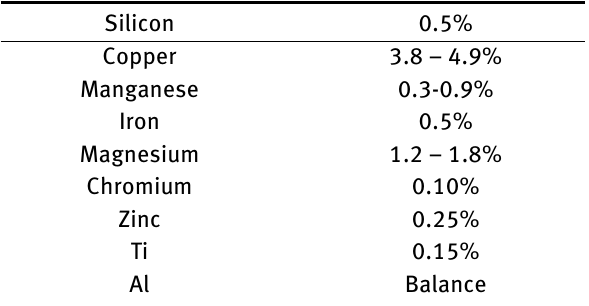
Table 3: Comparative Study of Ceramic Particles and RHA Composi-